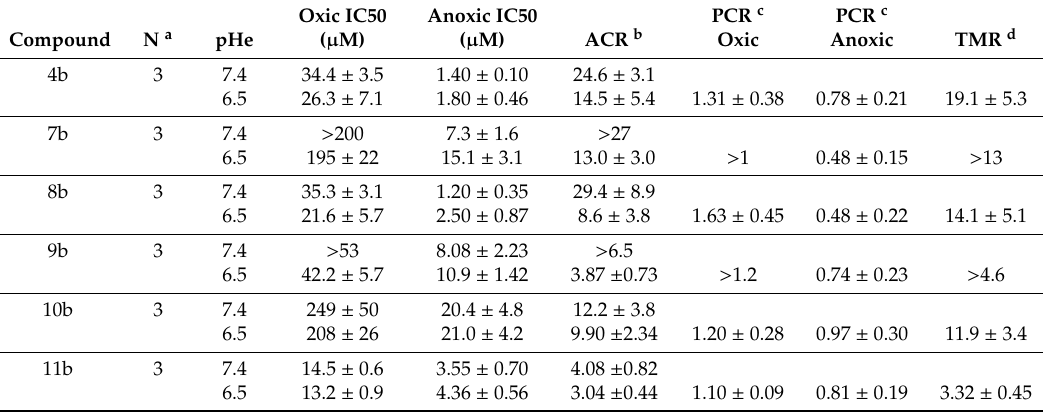
Table 5. Cytotoxicity of BTO esters against SiHa cells by IC 50 assay after 4 h of exposure at pHe 7.4 or 6.5 under oxic or anoxic conditions.